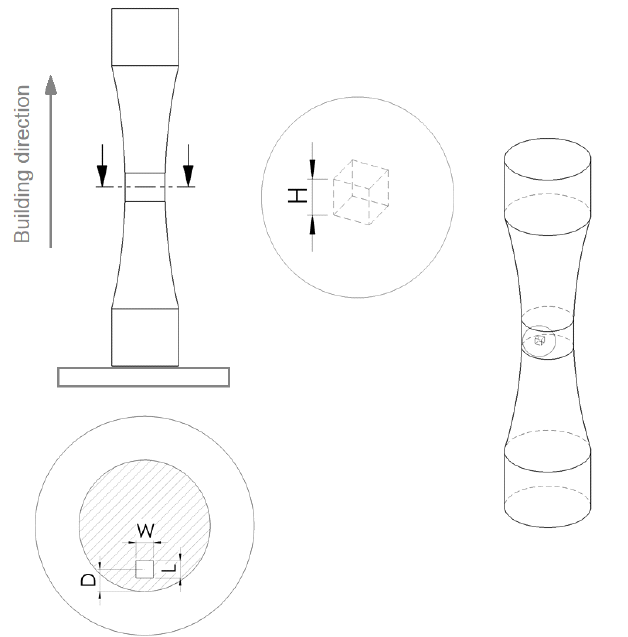
Figure 1. Schematic depiction of the coupon configurations on the build plate, including the induced artificial internal cubic defect.